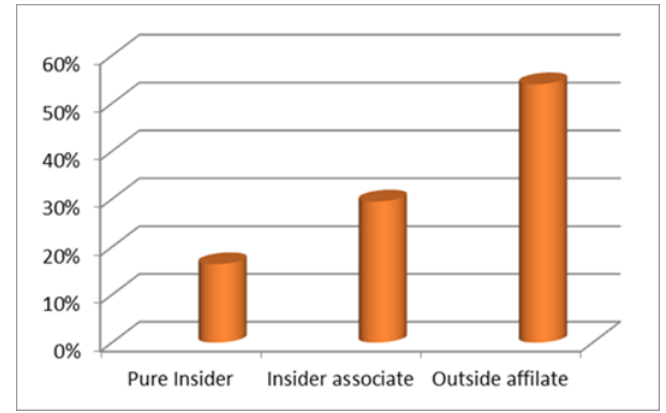
Figure 7. Level of Figure 7. Level of insider.